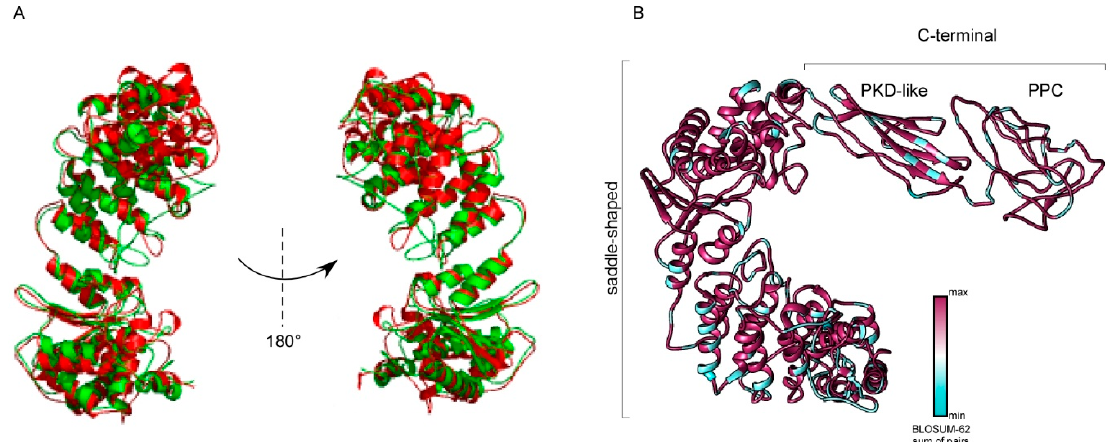
Figure 5. Ribbon diagrams of the collagenase structures herein defined. The 3D structures were created via the Phyre 2 software and rendered by using Chimera package. ( A ) Superposition of three-dimensional models in ribbon representation of the catalytic domain of VppC (green) and VAC (red). ( B ) Three-dimensional model of VppC with corresponding structure colored according to the conservation of amino acids among class III collagenase of M9A subfamily from V. alginolyticus and V. parahaemolyticus . Variable positions are presented in light-blue; while conserved amino acids are showed in magenta as defined in the color-coding bar.